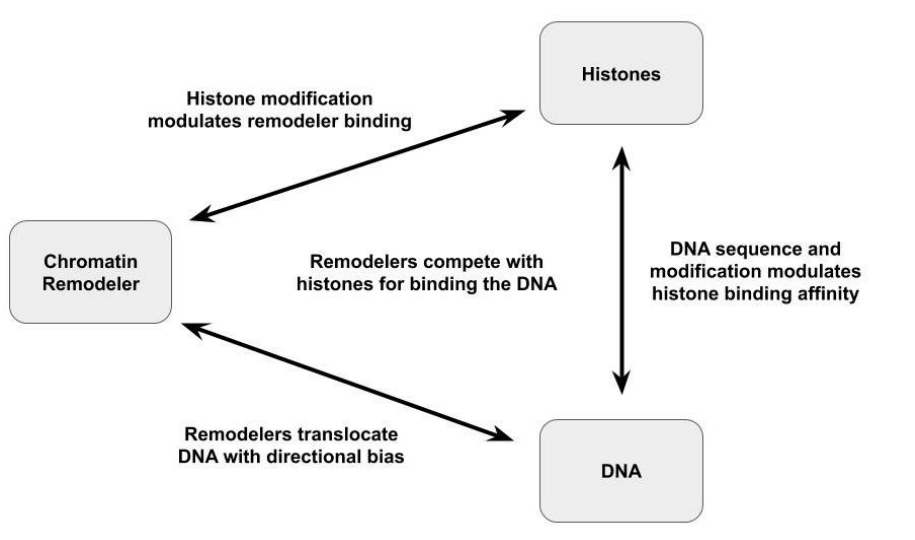
Figure 4. The network of interactions between the DNA, histones, and the chromatin remodelers that influence nucleosome